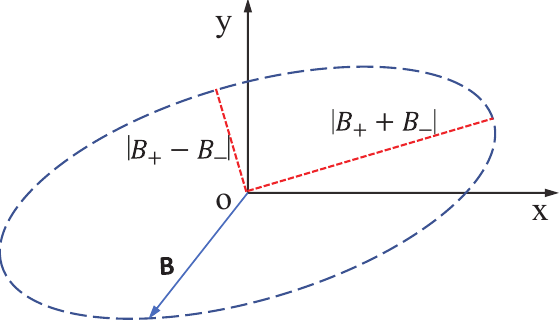
Figure 1. At a fixed point in space (or for fixed z), the magnetic vector B of a polarized microwave (MW) field traces out an ellipse in the xoy